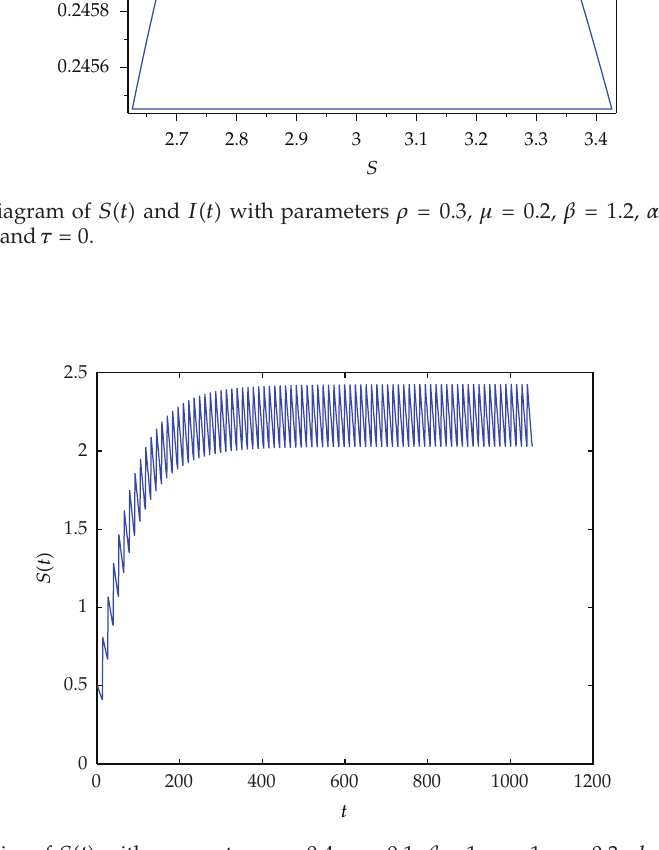
Figure 13: Time series of S (cid:3) t (cid:4) with parameters ρ (cid:7) 0 . 4 , μ (cid:7) 0 . 1 , β (cid:7) 1 , α (cid:7) 1 , r (cid:7) 0 . 3 , d (cid:7) 0 . 2 , ω (cid:7) 0 . 2 , T (cid:7) 0 . 8 , and τ (cid:7) 0 .